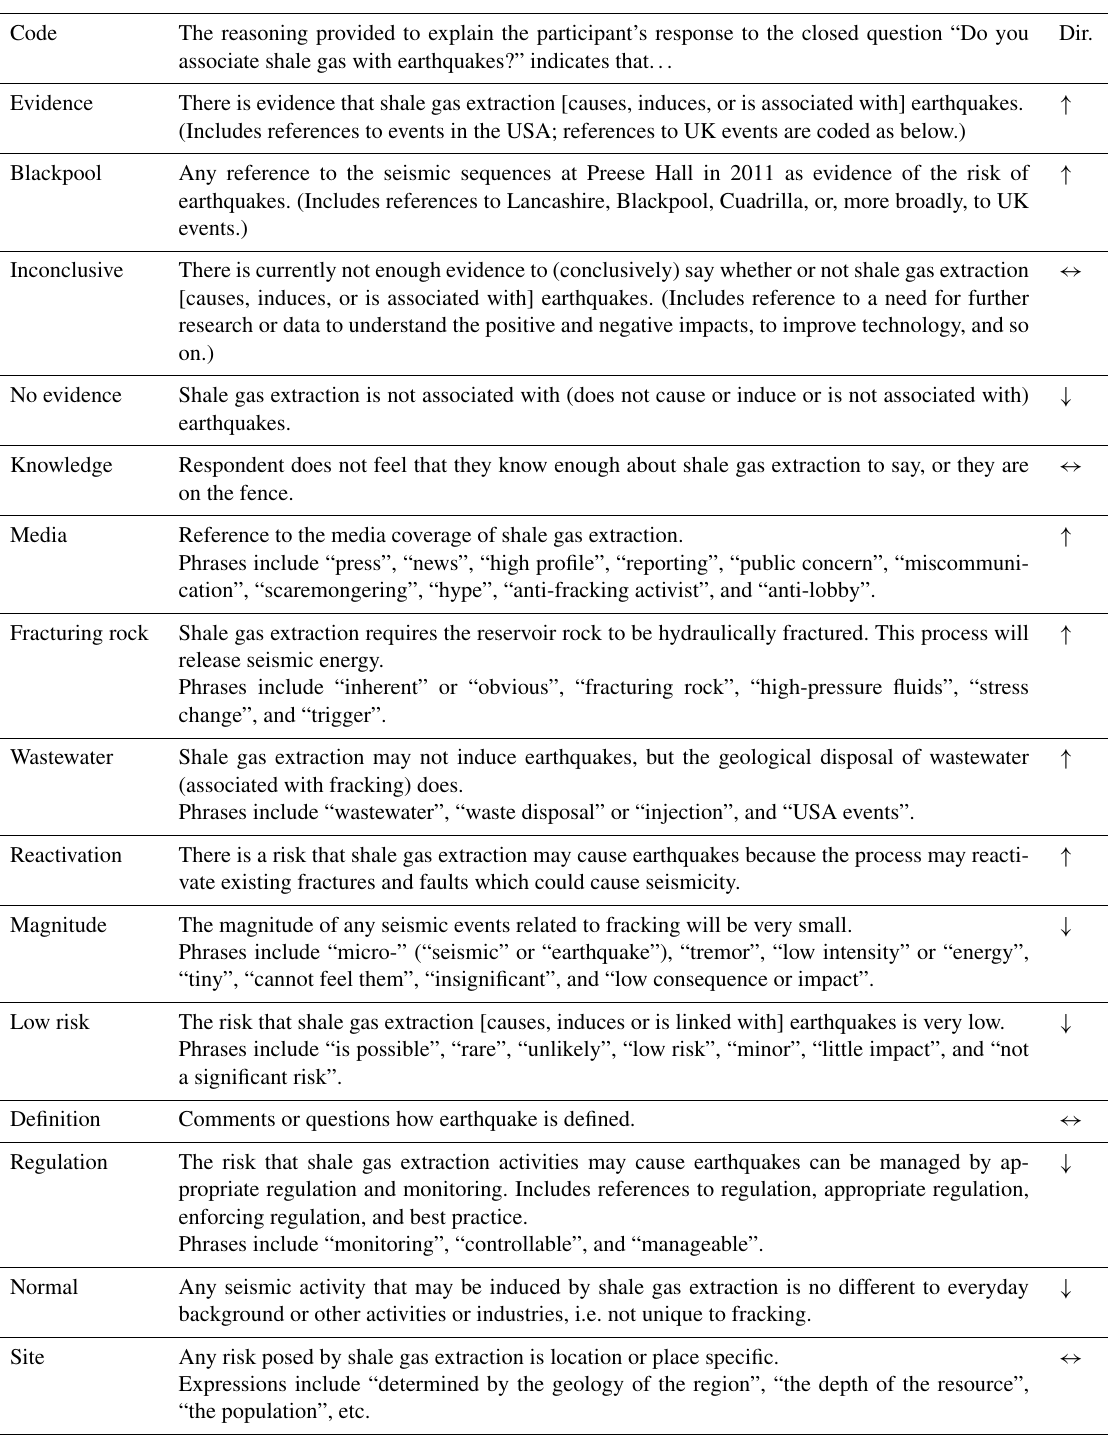
Table 4. Codes identified for thematic analysis of participant responses to an open question asking them to provide reasoning for the answer they gave to the closed question “Do you associate shale gas with earthquakes?” The codes are often directional, i.e. they are used to reason why earthquakes may be associated with shale gas (positive – ↑ ) or why earthquakes may not be associated with shale gas (negative – ↓ ). If the code is not directional, it is considered to be neutral ( ↔